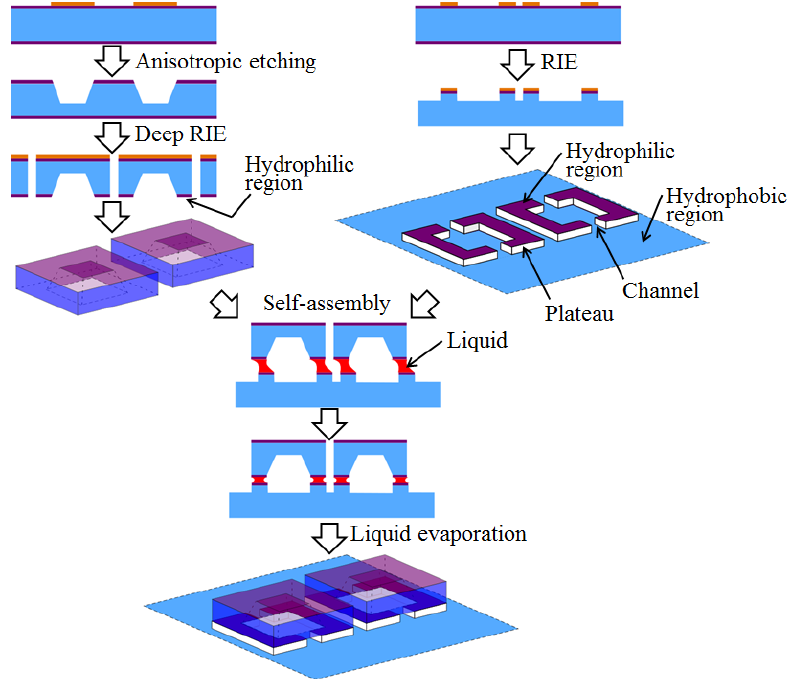
Figure 14. A process flow of the fabrication of chips with cavities and substrates with